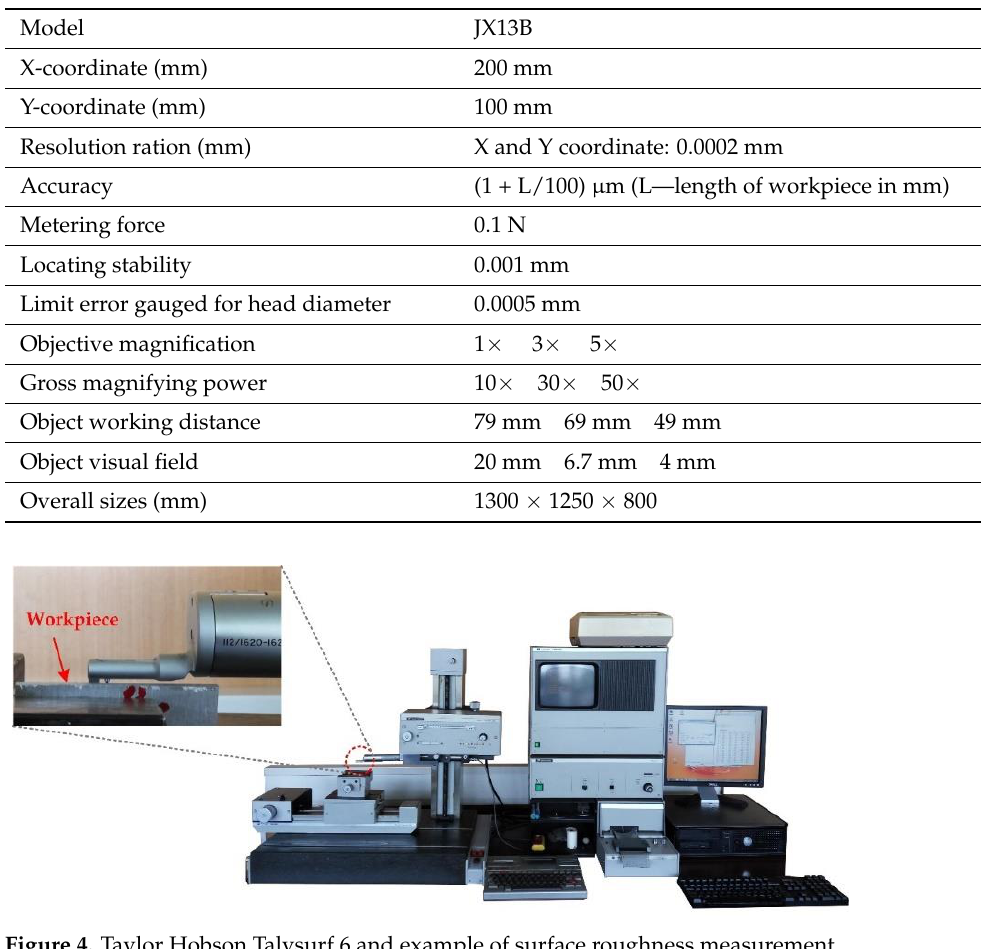
Figure 4. Taylor Hobson Talysurf 6 and example of surface roughness measurement. Table 4. Specifications of Universal Toolmaker’s Microscope . trial are listed in Table